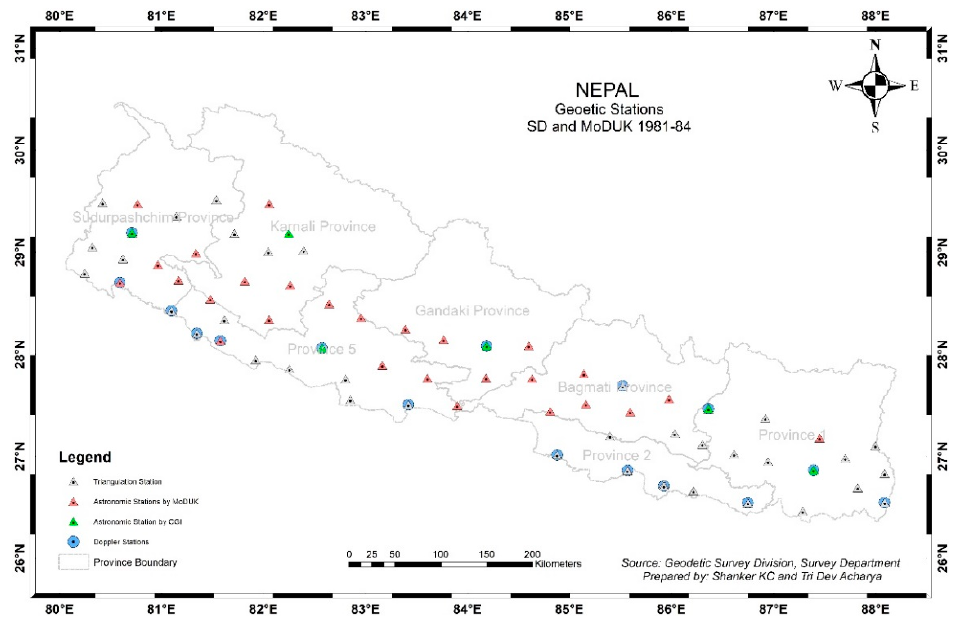
Figure 7. Control stations of Nepal datum [8].